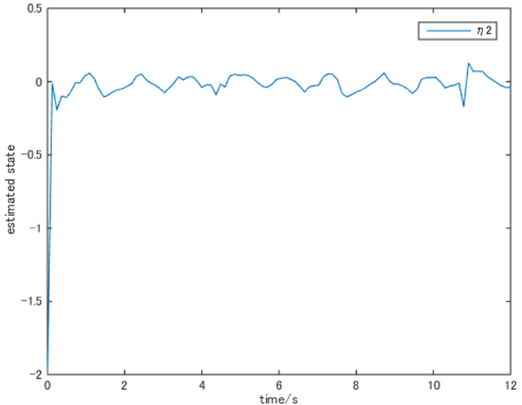
( ) x t . Figure 3. The trajectory of state x 2 ( t ) . 2